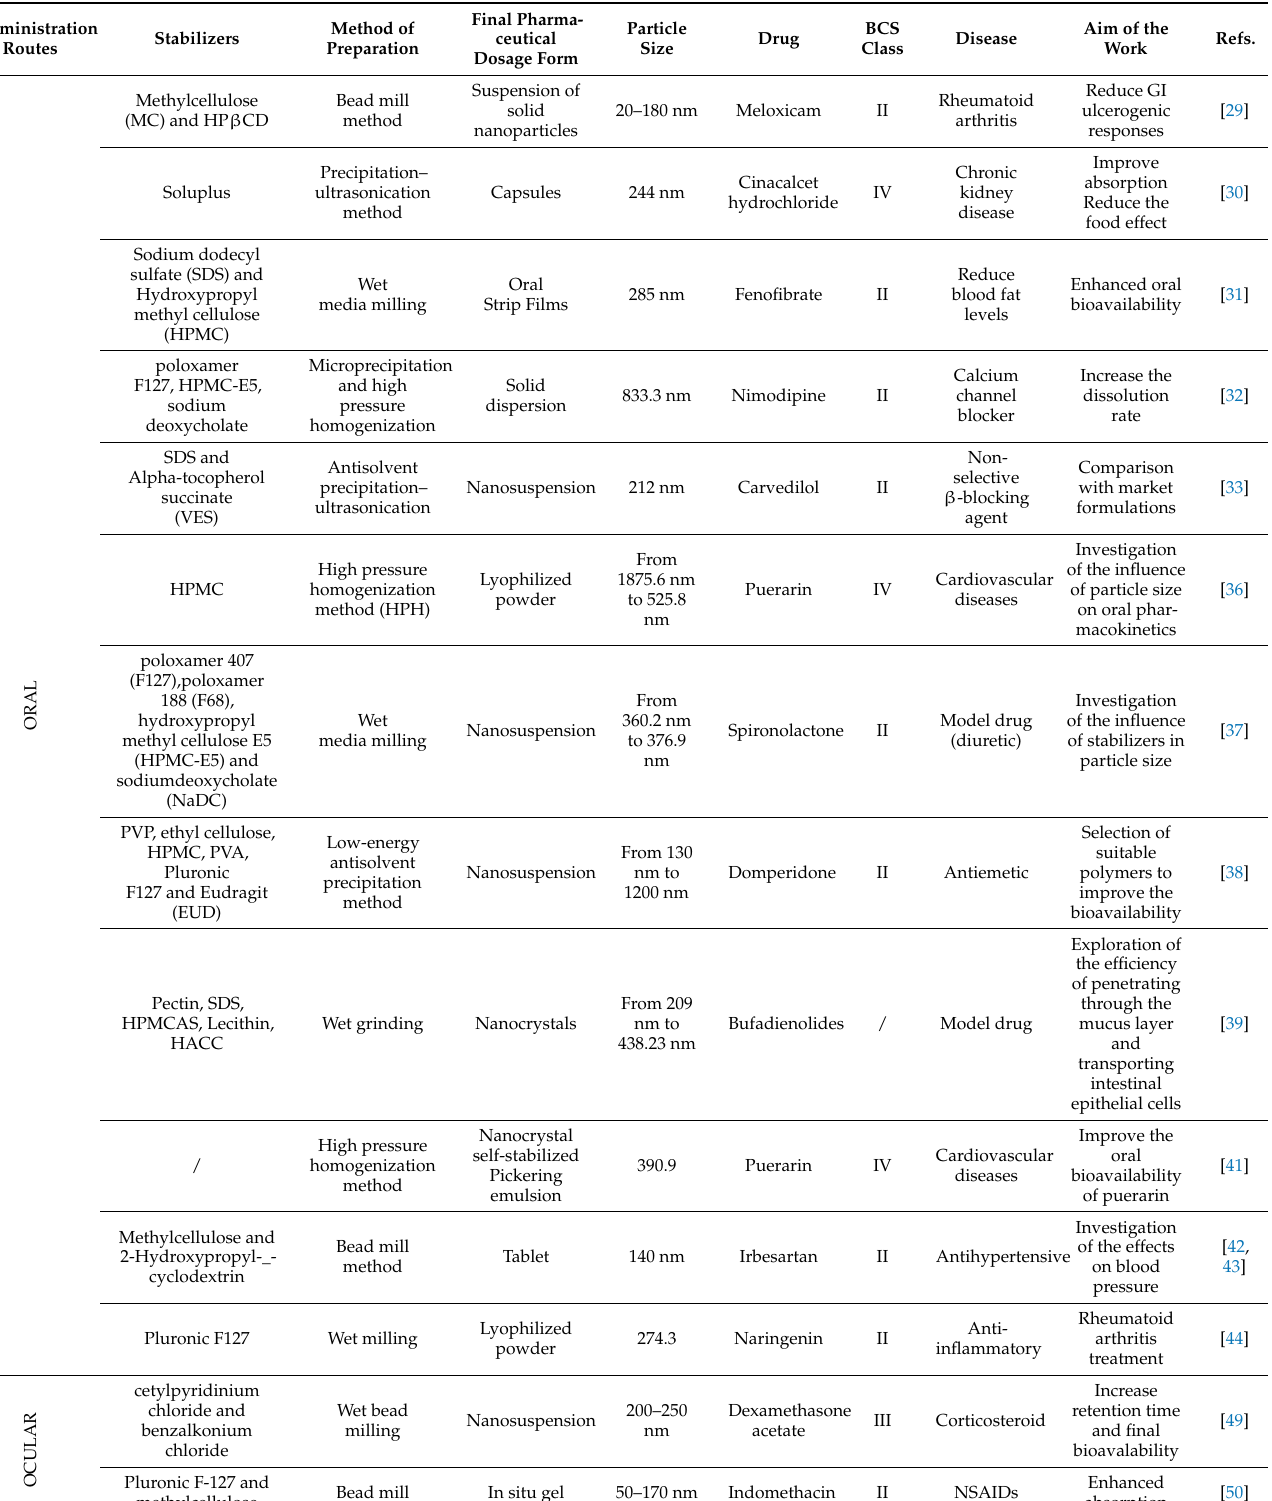
Table 1. NCs for different routes of